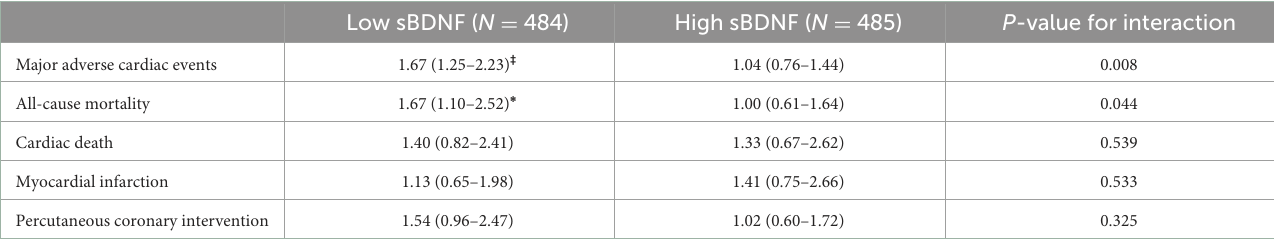
TABLE 1 Associations of a higher average BDNF methylation level at baseline with long-term cardiovascular outcomes in patients with ACS according to the sBDNF level. Low sBDNF ( N = 484) High sBDNF ( N = 485) P -value for